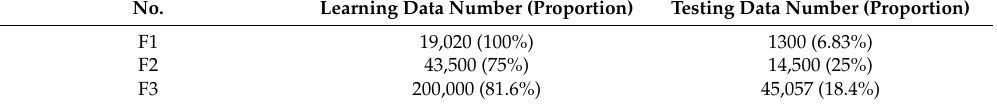
Table 3. Numbers and proportions of data sets in the approximate Newton-type neural network with random weights (ANE-NNRW).